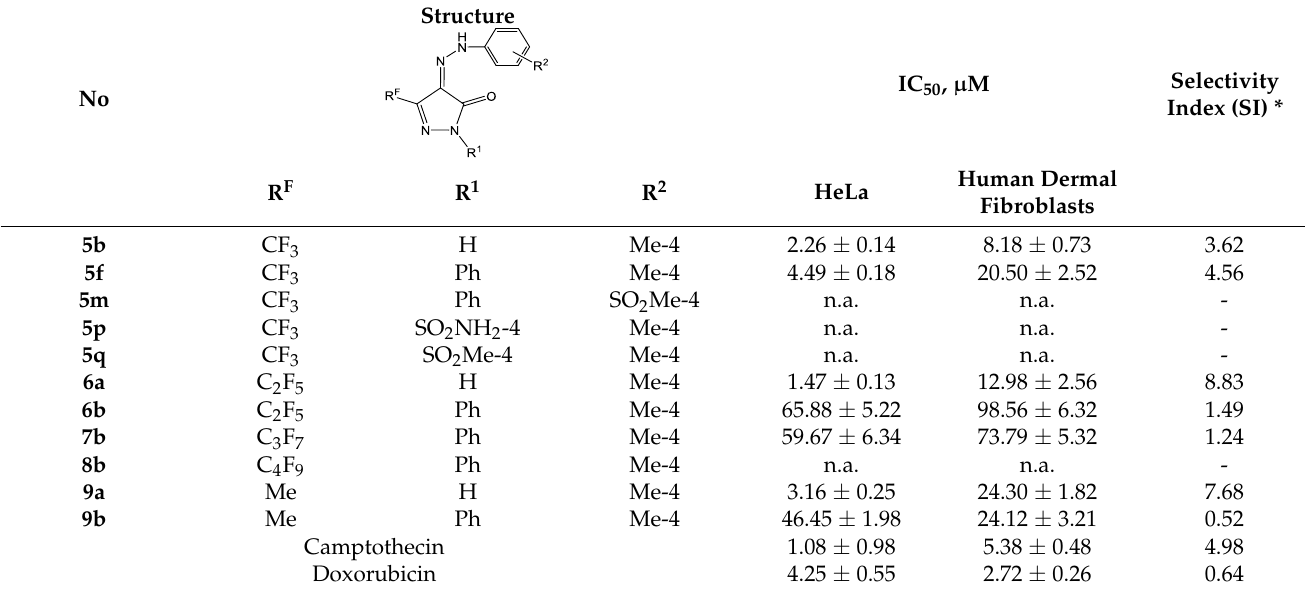
Table 7. Cytostatic activity (IC 50 ) of pyrazolones 5b,f,m,p,q, 6a,b, 7b, 8b, 9a,b against HeLa cell line and human dermal fibroblasts.